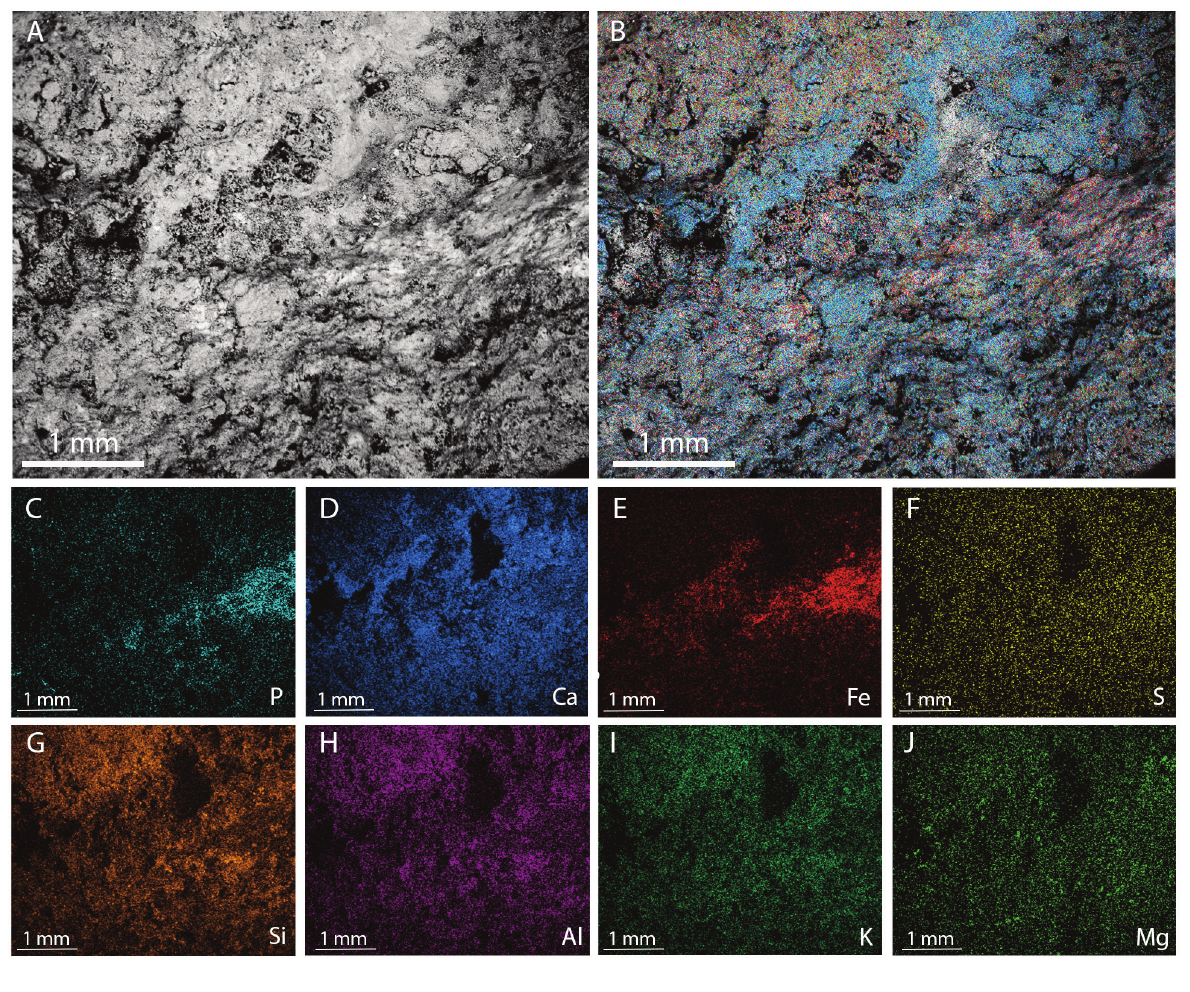
Fig. 6. Elemental composition of the boundary between the proximal matrix (‘tube’) around the specimen (above) and the peripheral matrix (below). A , EDS view of the boundary region between two types of matrices; B , composite image of the EDS element distribution maps; C – J , EDS element distribution